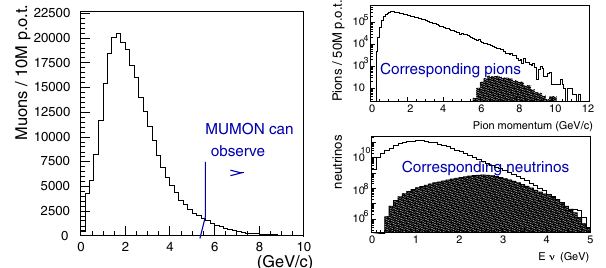
Fig. 14 Energy distributions of the muons (left), pions (right top) and neutrinos (right bottom) from the pion decay in the K2K neutrino beam line after the horn focusing [30]. The shaded histograms correspond to the beam components with the muons above 5.5 GeV that are observed by